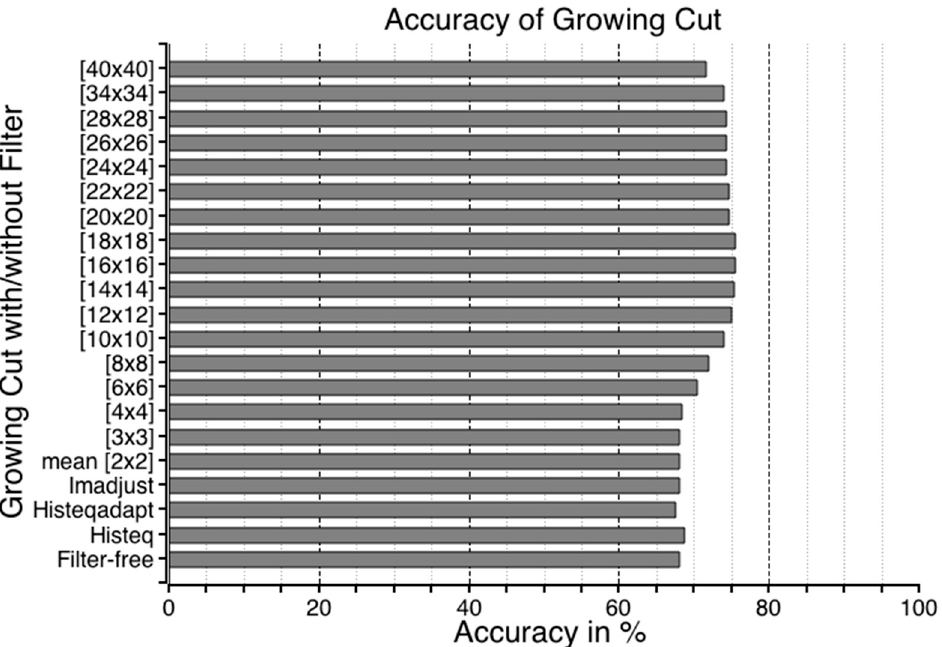
Figure 11. GrowCut accuracy. The accuracy was determined according to the ground truth. Each horizontal bar shows the accuracy with a different filter: viz., the mean, imadjust, histeqadapt, histeq, and filter-free GrowCut. The highest accuracy is 75.2% with the mean filter and both 18 × 18 and 16 × 16 masks.